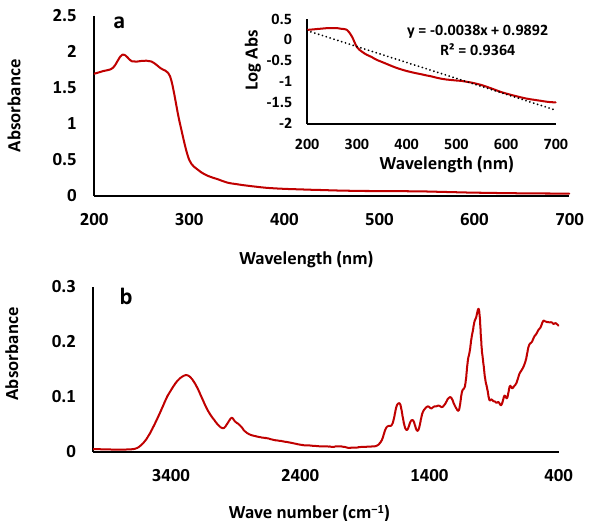
Figure 1. Absorption spectra of date fruit melanin ( a ) UV–visible and ( b ) Fourier-transform infrared